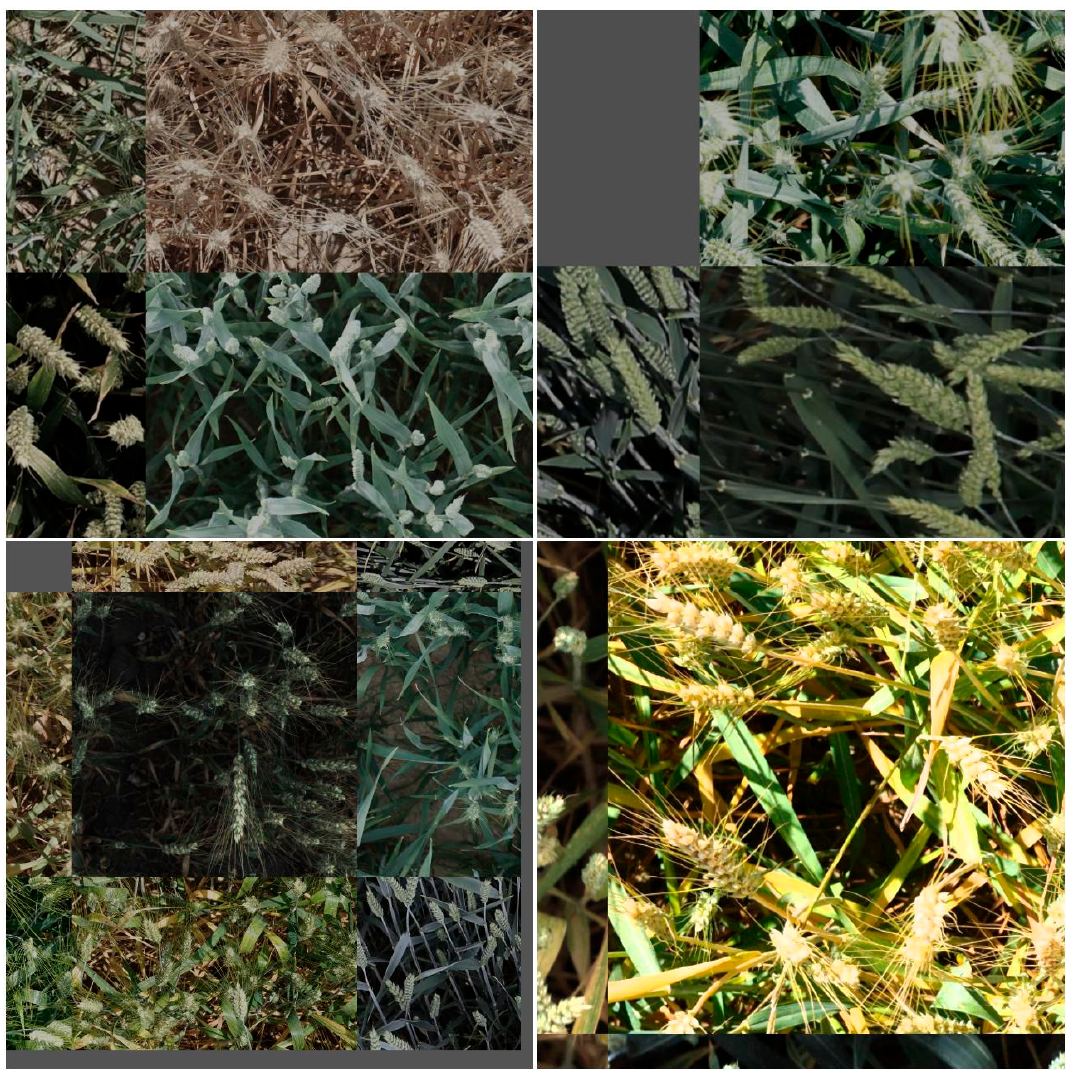
Figure 5. Schematic diagram of part of the Mosaic-8 data augmentation .